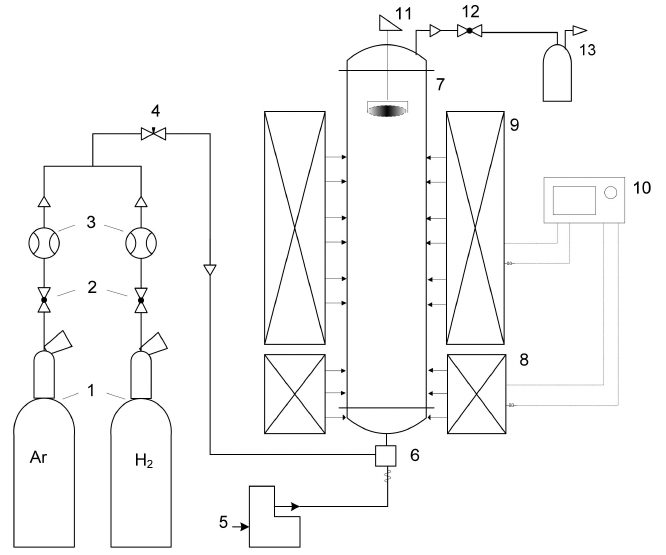
Figure 3. Schematic representation of the laboratory setup: 1—He, H 2 cylinders; 2, 12—valve; 3—mass flow controller; 4—fine regulation valve; 5—liquid phase feeder; 6—mixer evaporator; 7—quartz tube reactor; 8—preheater; 9—furnace; 10—temperature regulator; 11—rotating harvester; 13—filter system.